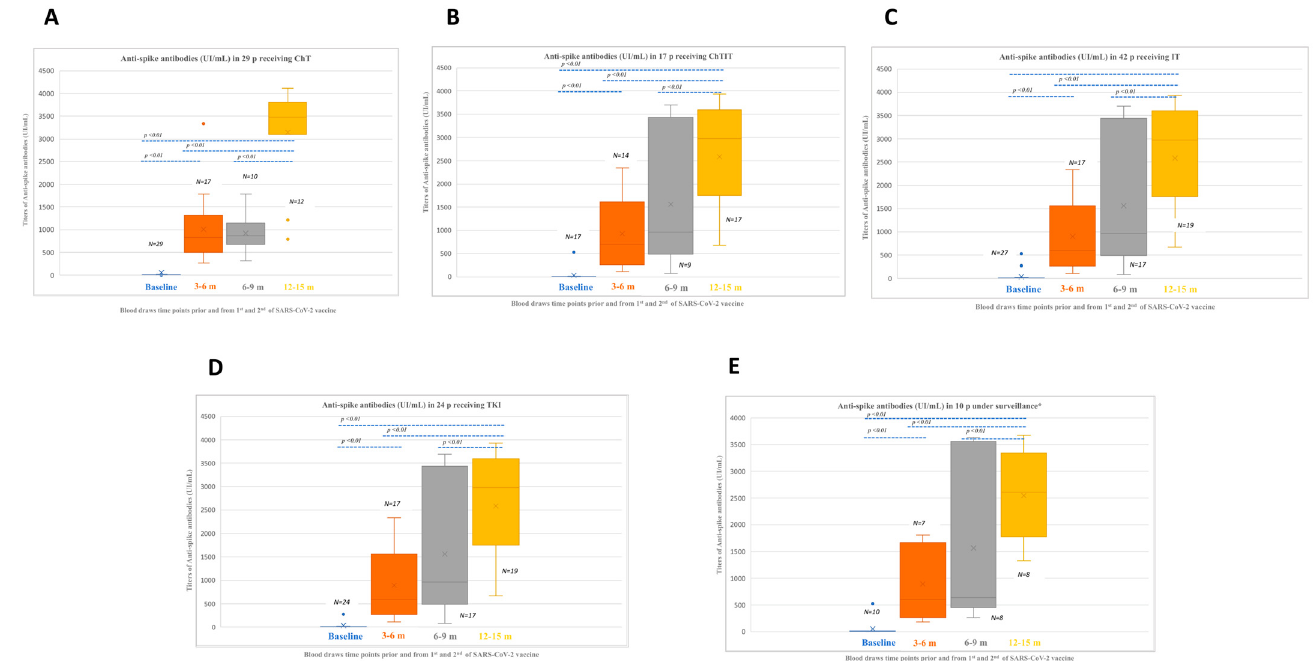
Figure 3. Anti-spike antibodies titers disposition according to type of anticancer therapy in a cohort of 126 patients with lung cancer (baseline samples were evaluable from 122 patients). ( A ). Anti-spike antibodies in 29 patients receiving ChT; ( B ). Anti-spike antibodies in 17 patients receiving ChTIT; ( C ). Anti-spike antibodies in 42 patients receiving IT; ( D ). Anti-spike antibodies in 24 patients receiving TKI; ( E ). Anti-spike antibodies titers in 10 patients on surveillance *; Legend: ChT, chemotherapy; IT, immunotherapy; m, months; p, patients; RT, radiotherapy; TKI, tyrosine kinase inhibitor. * This group includes 9 patients on active surveillance and 1 patient receiving lantreotide.